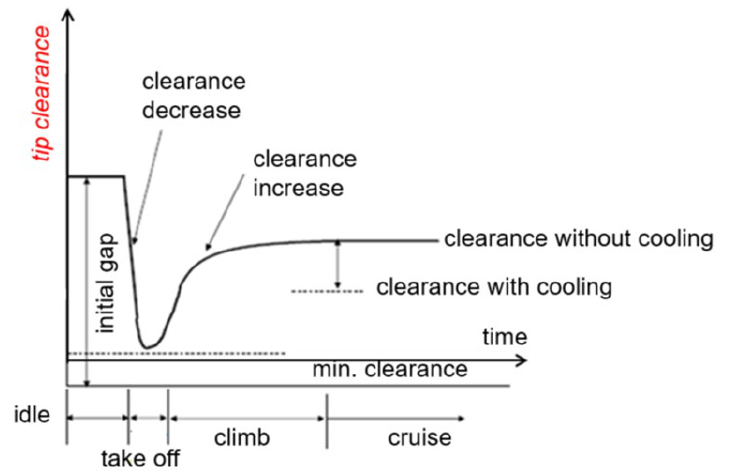
Figure 6. Tip clearance control